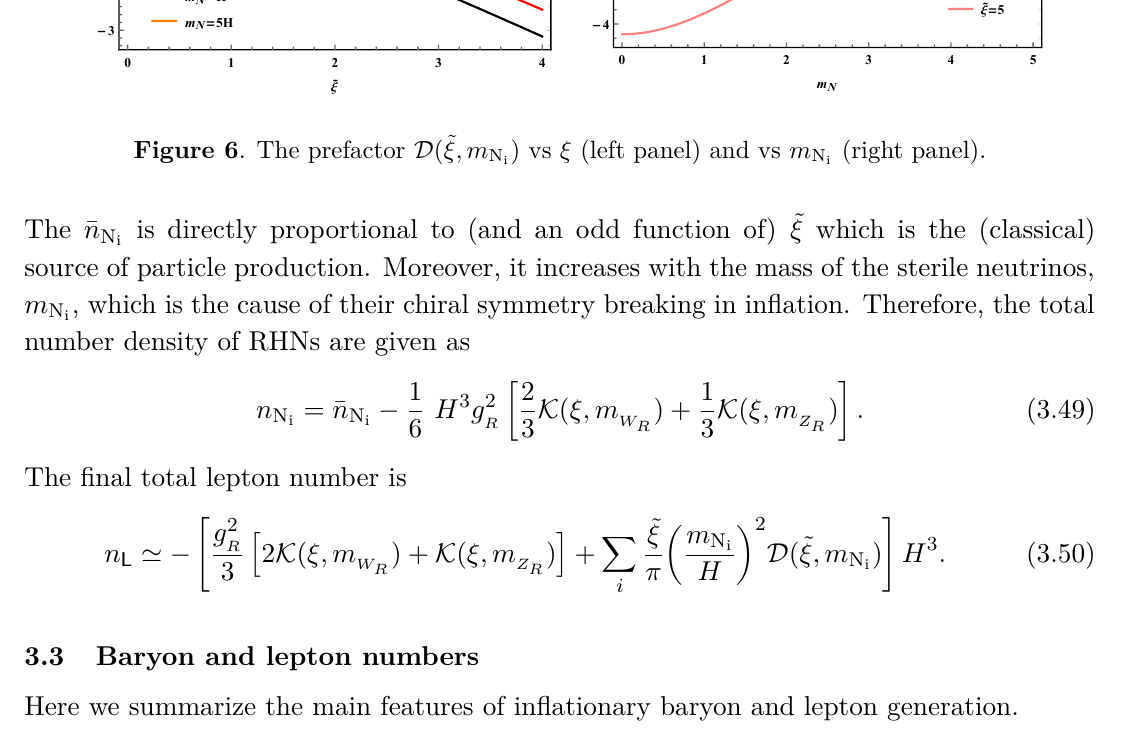
Figure 6 . The prefactor D